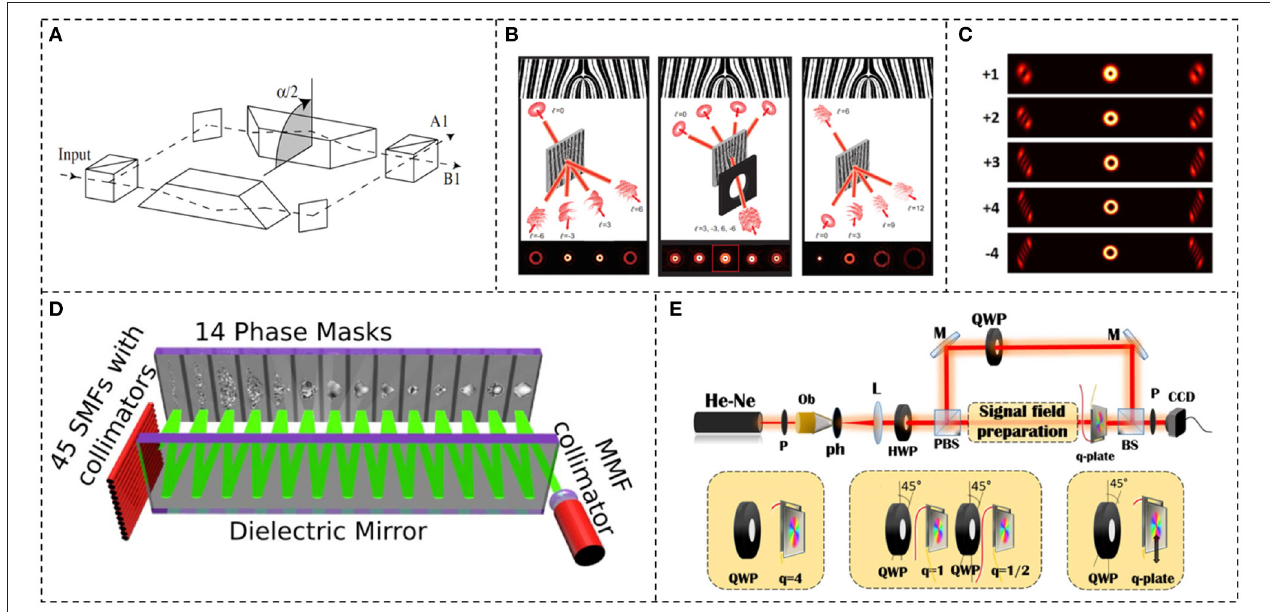
FIGURE 7 | Detection of spatial-structured light beams, utilizing discrete devices. (A) Sorting optical vortex beams, using a Dove prism. Reprinted from Leach et al. [74]. (B) Demultiplexing optical vortex superposition states, utilizing Dammann gratings. Reprinted from Lei et al. [75]. (C) Detection of optical vortex beams, using annular gratings. Reprinted from Zheng et al. [ 77]. (D) The MPLC device for HG/LG superposition state decomposition. Reprinted from Fontaine et al. [78]. (E) An experimental setup for decomposing optical vortex superposition state, using on-axis digital holography. Reprinted from D’Errico et al. [